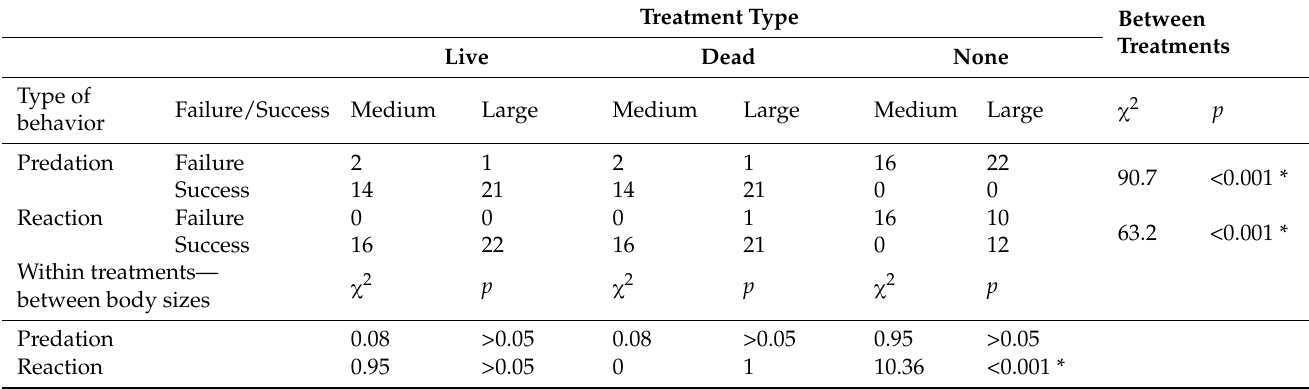
Table 1. Feeding on planktonic organisms by large and medium size Trapezia cymodoce crabs — summary results for laboratory experiments. Pearson’s chi-square followed by Fisher exact pair- wise tests of independence for nominal data analyses of predation and reaction behaviors (fail- ure/success) of individuals examined on different substrates: live corals (‘live’); coral skeletons (‘dead’); and without corals (‘none’), following the introduction of live Artemia . Asterisk indicates statistical